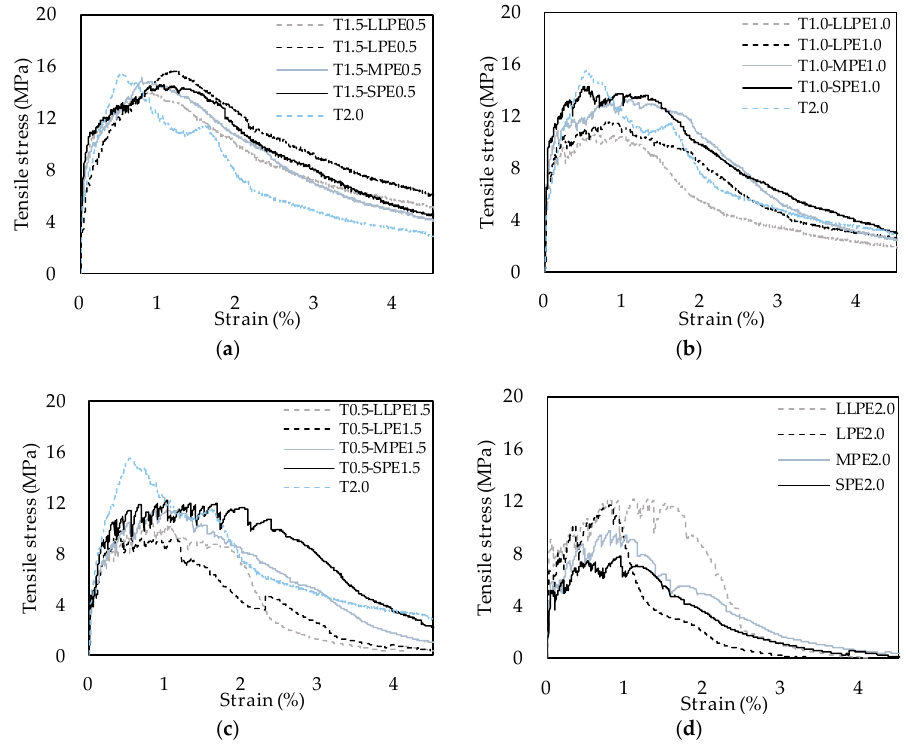
Figure 3. Tensile stress versus strain curves of ( a ) T0.5-PE1.5; ( b ) T1.0-PE1.0; ( c ) T1.5-PE0.5; and ( d ) PE2.0 series of specimens.